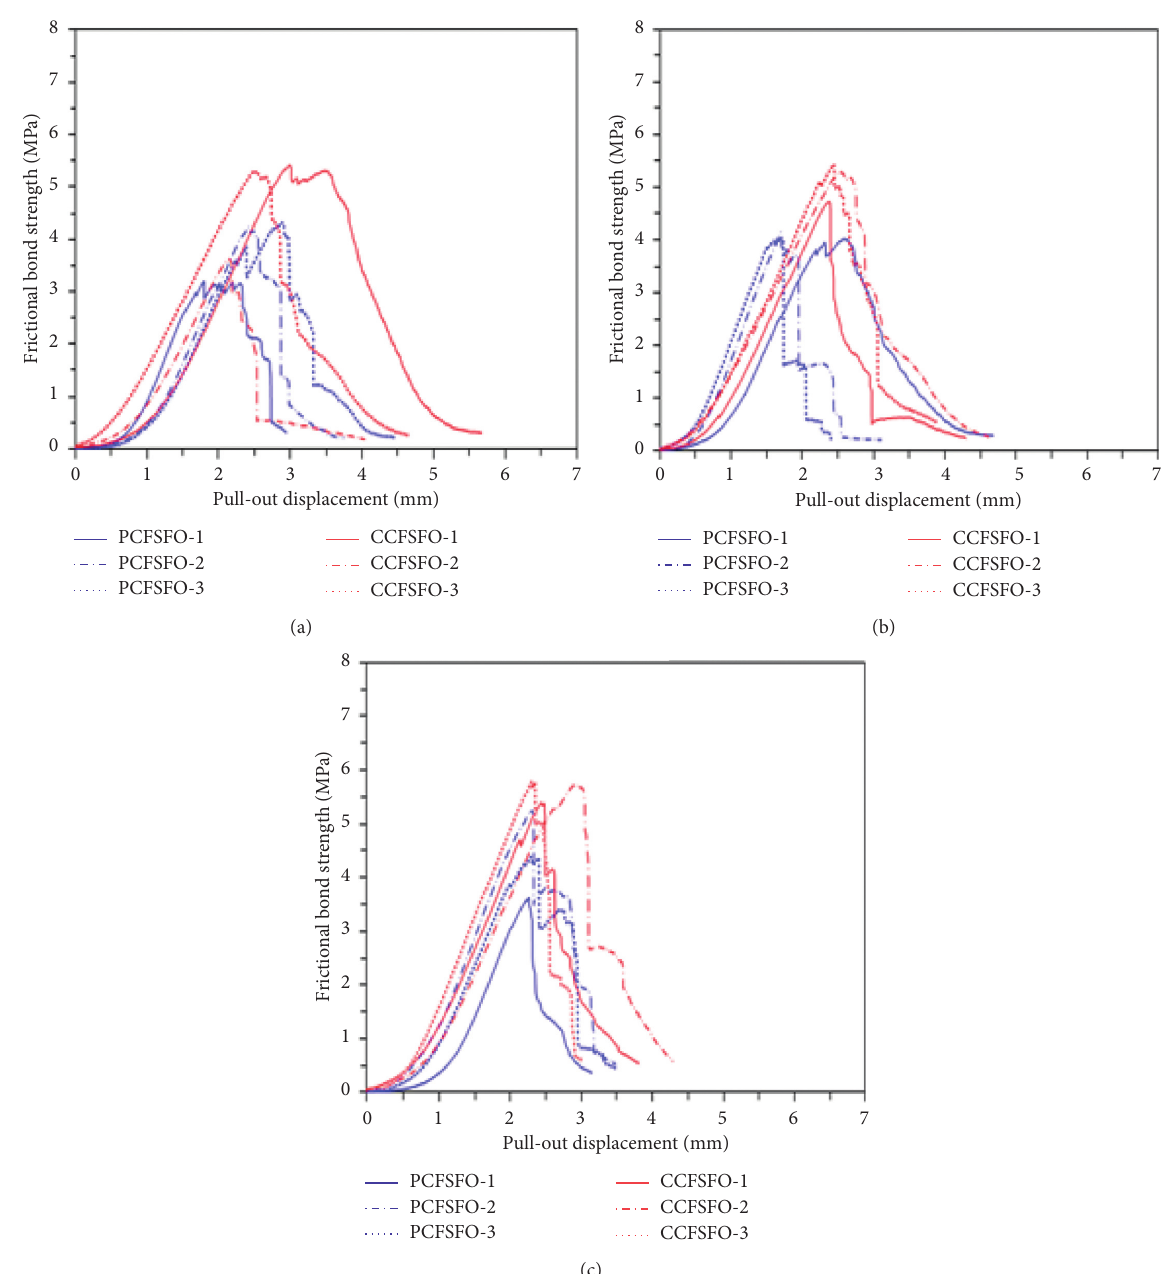
Figure 11: Stress-displacement curves of the pull-out test for the specimens without SF. (a) 3d. (b) 7d. (c)